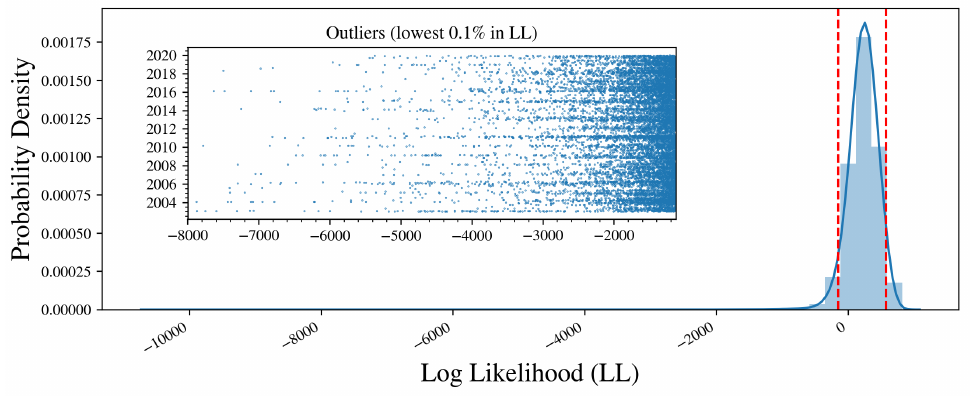
Figure 4. Distribution of LL values for the full dataset (modulo the training images). The majority are well described by a Gaussian centered at LL ≈ 240, with a tail toawrd much lower LL values. The inset shows the lowest 0.1% sample of LL, which we define as outlier cutouts. The striping apparent in the inset of Figure 4 indicates a non-uniform,